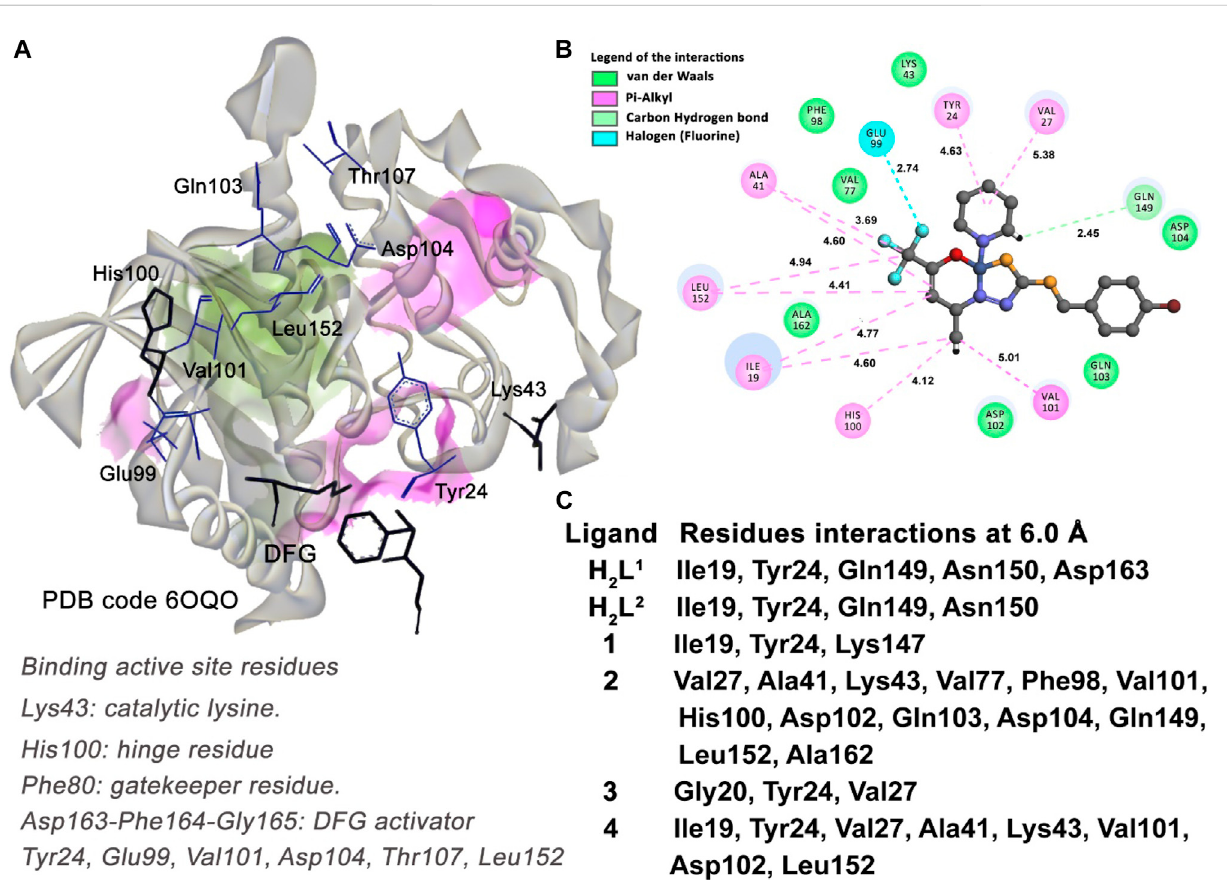
Molecular docking results of the U251 cell type target. (A) Binding active site regions of the CDK6 kinase protein ( 6OQO ) (Bronner et al., 2019), the DFG catalytic triad, and the gatekeeper residue His100 are also represented. (B) 2D representation of the interactions carried out between the best- ranked inhibitor, 2, and the active site. (C) Main nearest residues of both active sites of the 6OQO receptor (distance till 6.0 Å) and all the six compounds